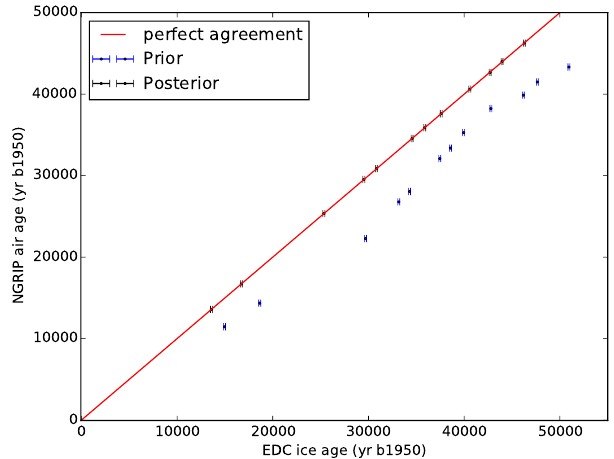
Figure 9. Experiment test-mixed-strati. NGRIP air age vs. EDC ice age for the prior (blue) and posterior (black) scenarios for the stratigraphic observations. The 1 : 1 perfect agreement line (red) is shown for comparison. This figure is automatically produced by